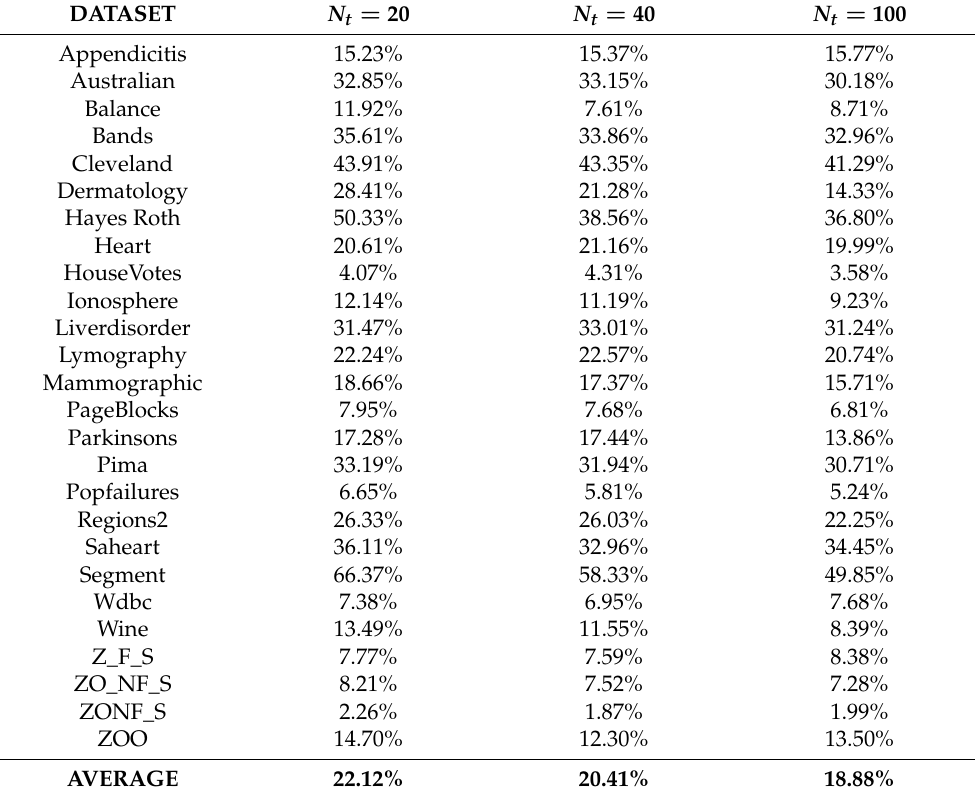
Figure 1. Execution time comparison between the proposed algorithm and the other mentioned methods. Table 4. Experiments with N t for the classification